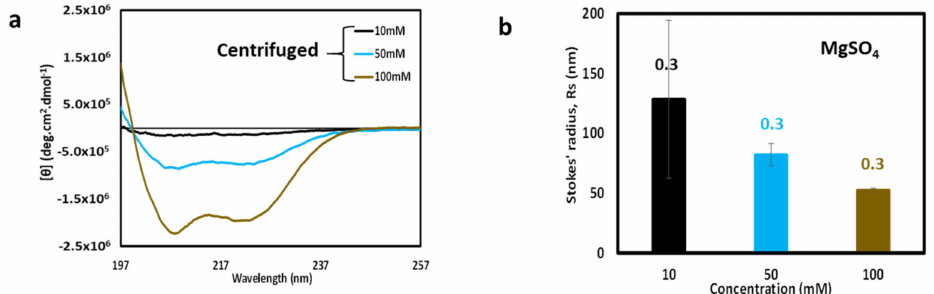
Figure 5. CD spectra and DLS analysis after centrifugation. ( a ) Overlay of CD spectra of supernatant after centrifugation of cl-Par-4 at various concentrations of MgSO 4 . The salt concentrations are indicated by the color legend within the panel. ( b ) Corresponding DLS of samples from panel ( a ). Error bars represent the standard deviation in Stokes’ radii from multiple runs, and the number above each bar represents the average polydispersity value for these runs.